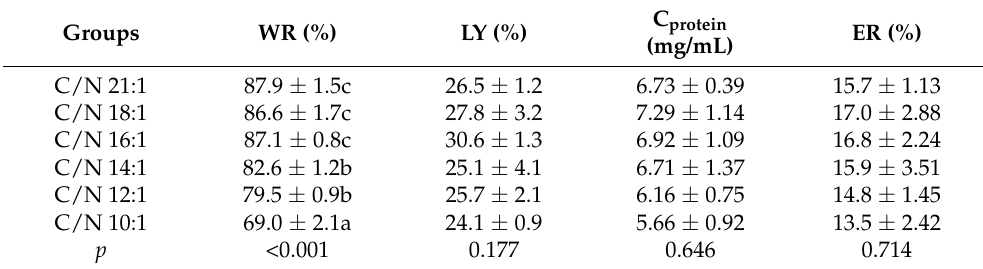
Table 1. The bioconversion performance and AMP extraction rate of BSFL under different C/Ns.